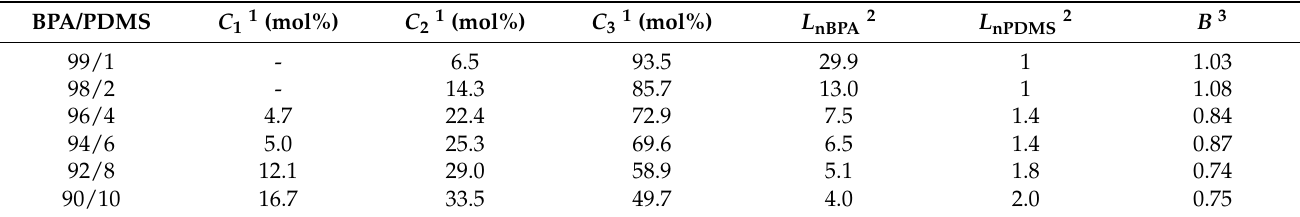
Table 3. Microstructure of silanol-terminated PDMS copolycarbonates with different feed ratios of BPA to PDMS. BPA/PDMS